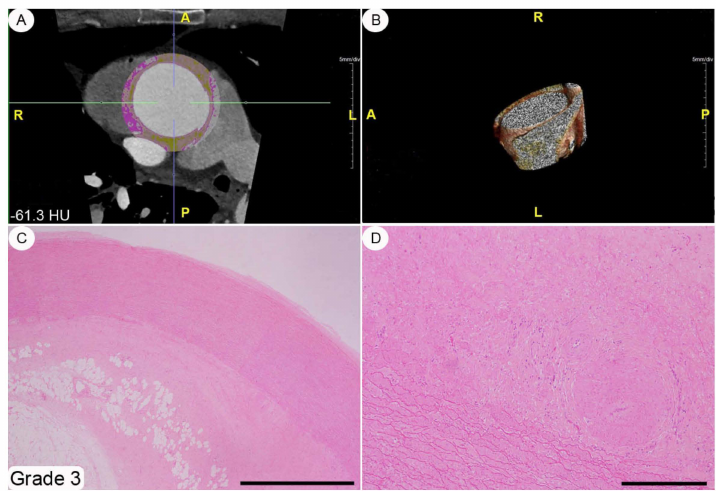
Figure 4. Adventitial fibrosis, grade 3. This index case refers to a 71-year-old male/female pa- tient with AA aneurysm with, an attenuation histogram of peri-vascular adipose tissue of mean − 61.3 HU ( A , B ). The resultant histopathology shows a moderate increase in tunica media thickness ( C ) as well as a severe fibrosis of the adventitial adipose tissue with a trespassing on the periadventi- tial soft tissues. Only sparse adipose tissue islands are detectable in the adventitial/periadventitial spaces ( C ). The fibrotic tissue is dense and scarcely cellular ( D ). Staining. ( C , D ): hematoxylin-eosin. Original magnifications. ( C ): × 2 (bar is 1 mm), ( D ): × 10 (bar is 250